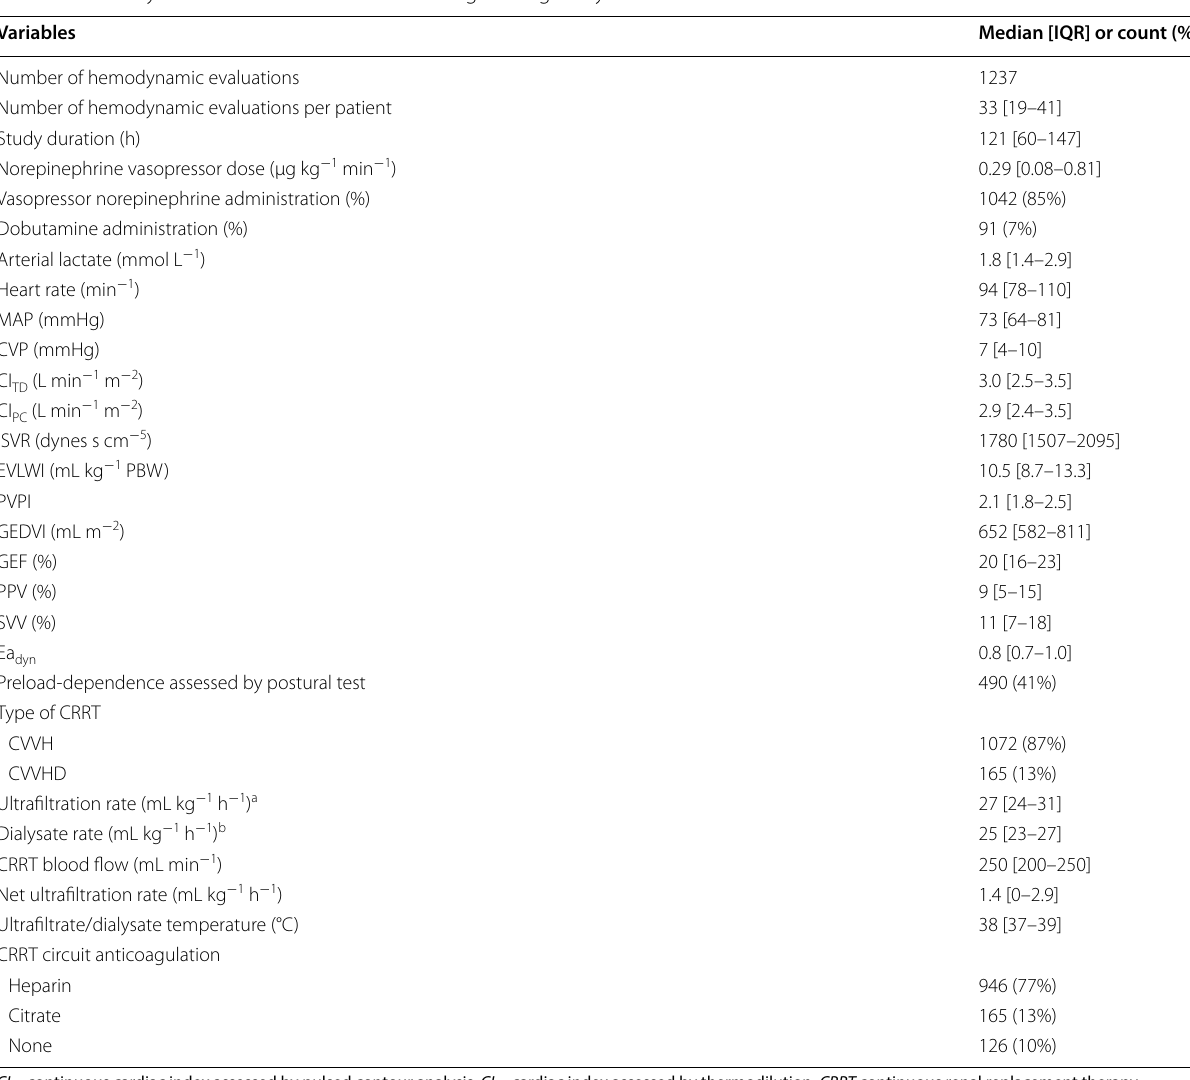
CI PC continuous cardiac index assessed by pulsed contour analysis, CI TD cardiac index assessed by thermodilution, CRRT continuous renal replacement therapy, CVP central venous pressure, CVVH continuous veno-venous hemofiltration, CVVHD continuous veno-venous hemodialysis, Ea dyn dynamic arterial elastance, EVLWI permeability index, SVV stroke volume variation a In patients treated with CVVH b In patients treated with CVVHD